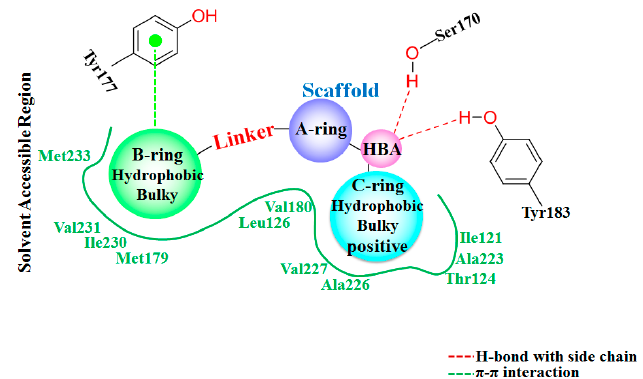
Figure 5. Summary of structure-activity relationships based on docking and 3D-QSAR investigation.